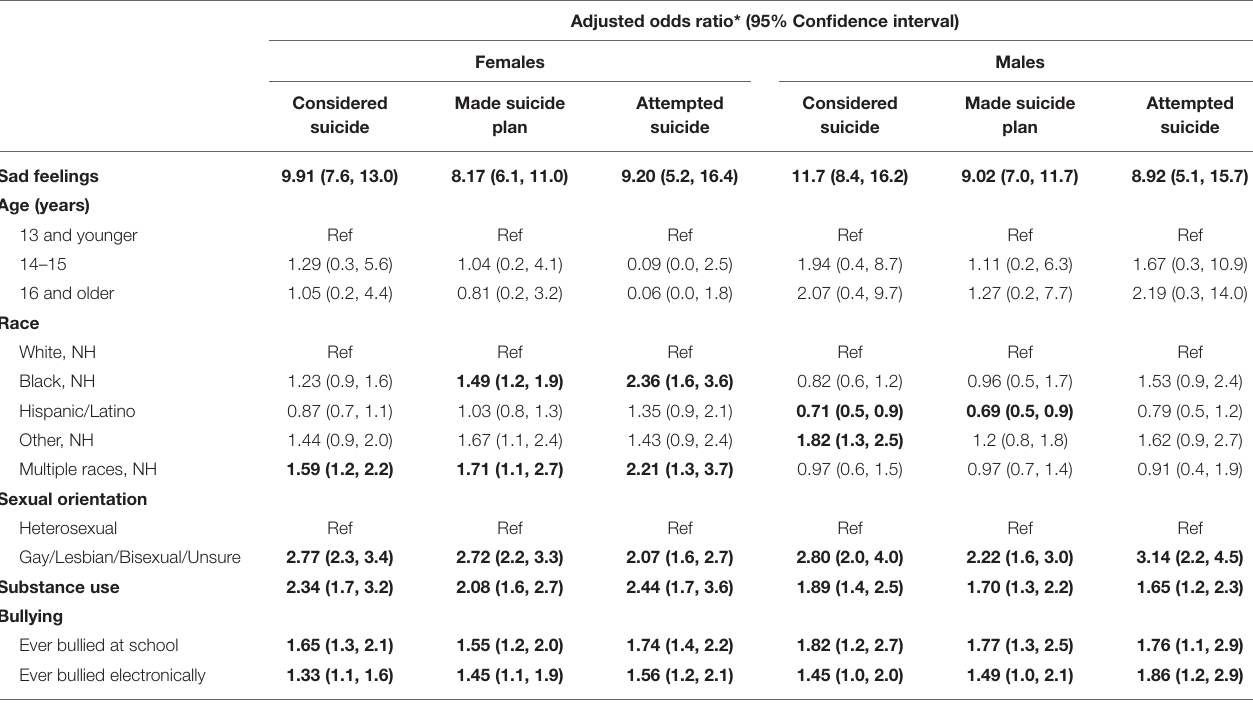
TABLE 3 | Association between feelings of sadness or hopelessness and suicidal behaviors, stratified by sex, among high school students in the YRBS 2019 ( N =